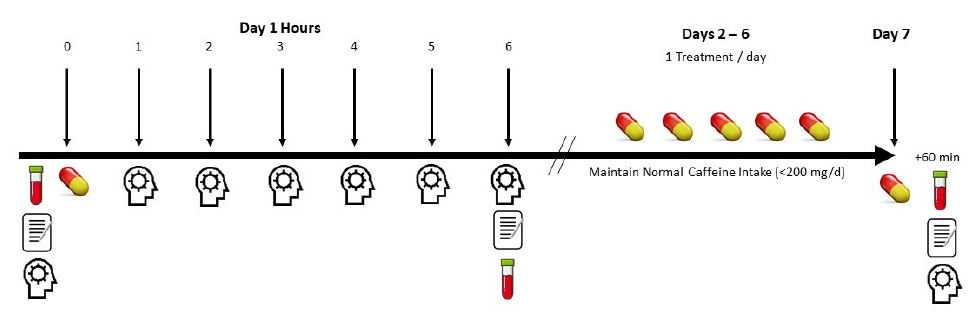
Figure 2. Overview of study protocol.